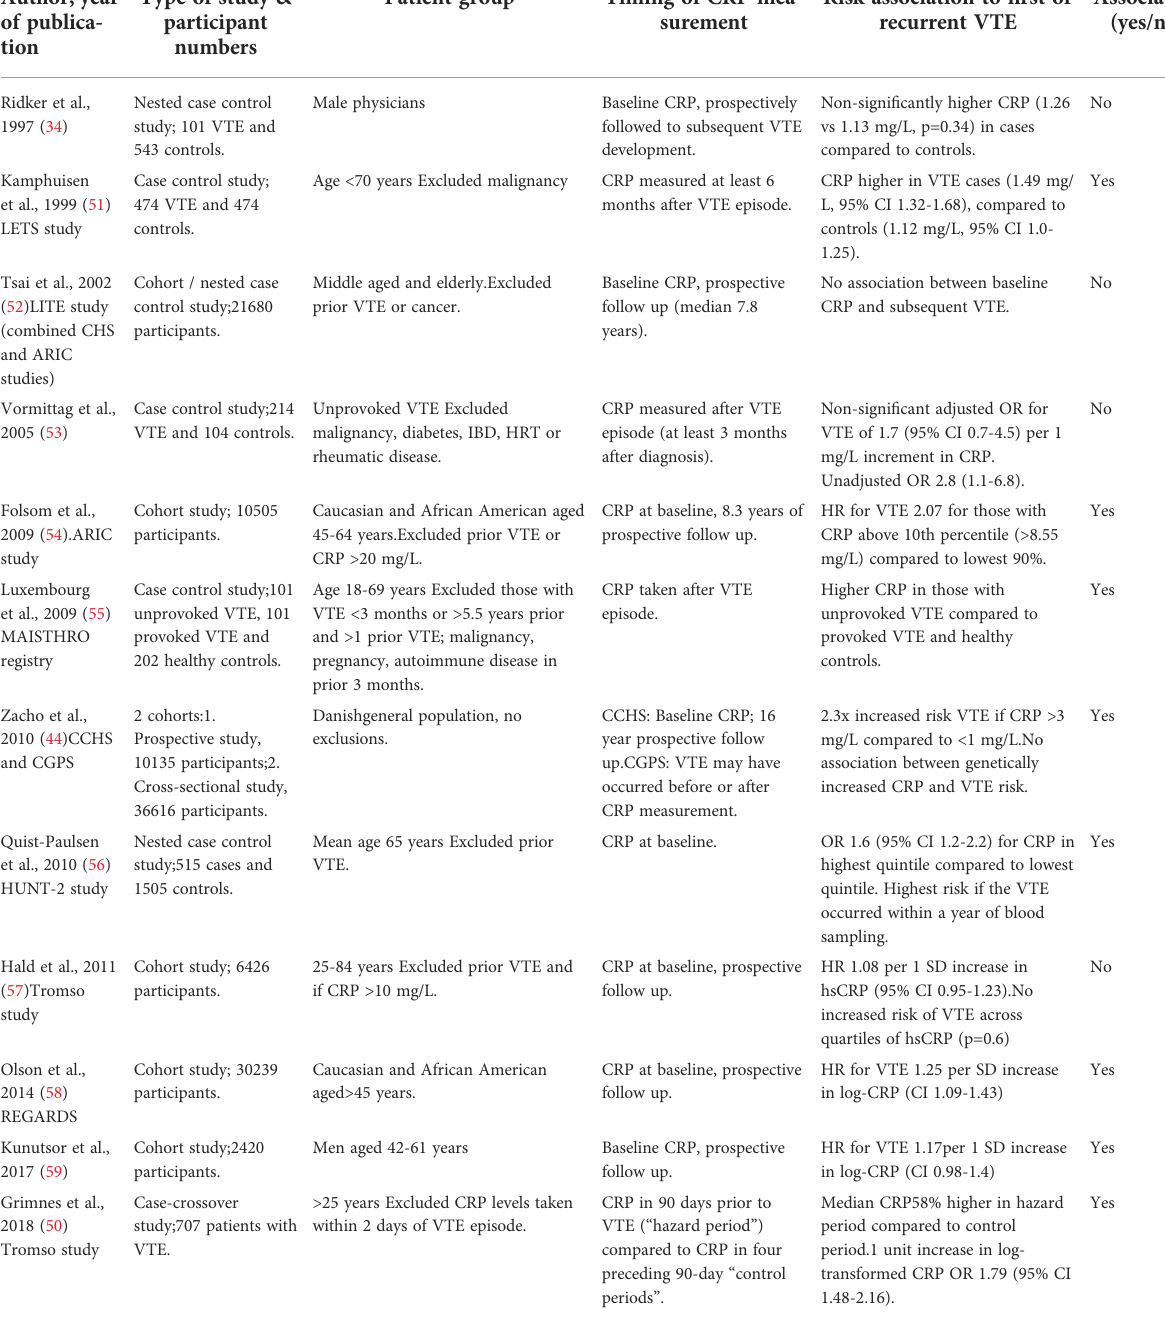
TABLE 1 Summary of population-based studies assessing the relationship between circulating CRP levels and